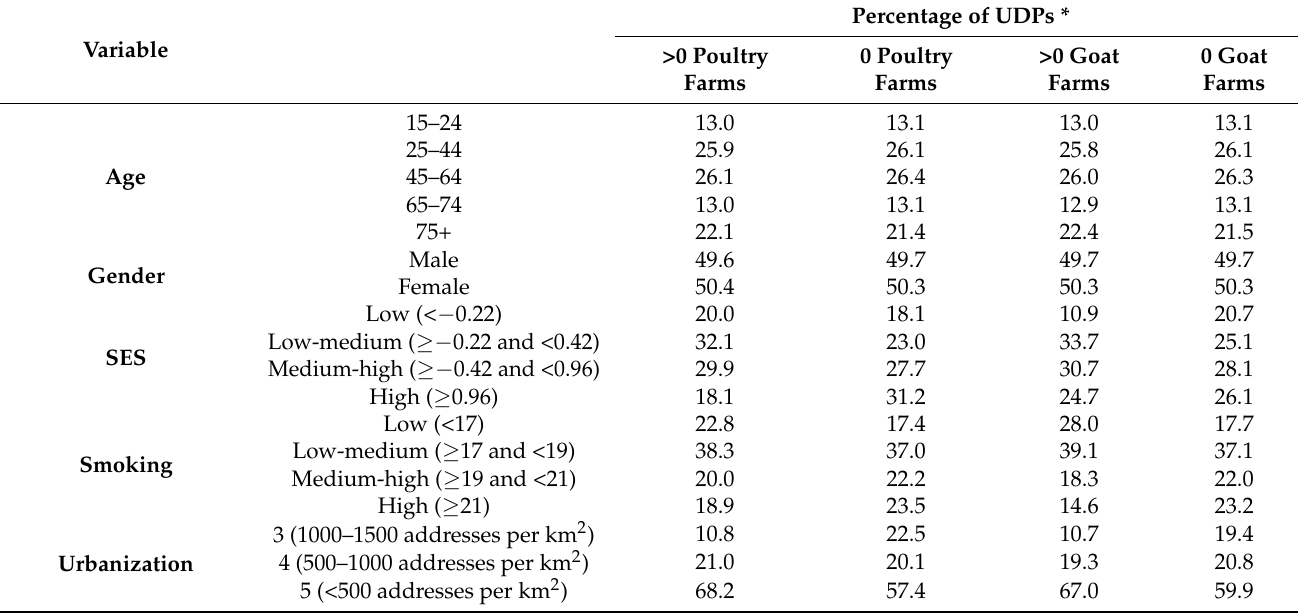
Table 1. Population characteristics of Unique Data Points (UDPs) with and without poultry/goat farms.